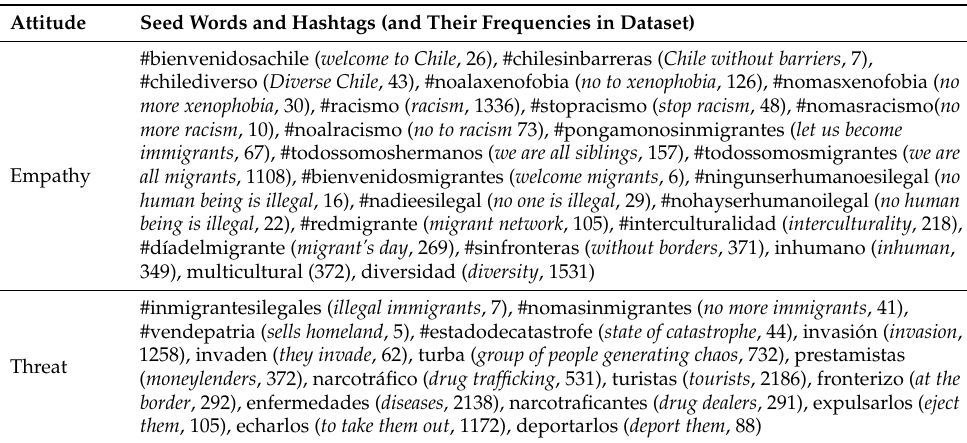
Table 1. Seed patterns for each attitude toward